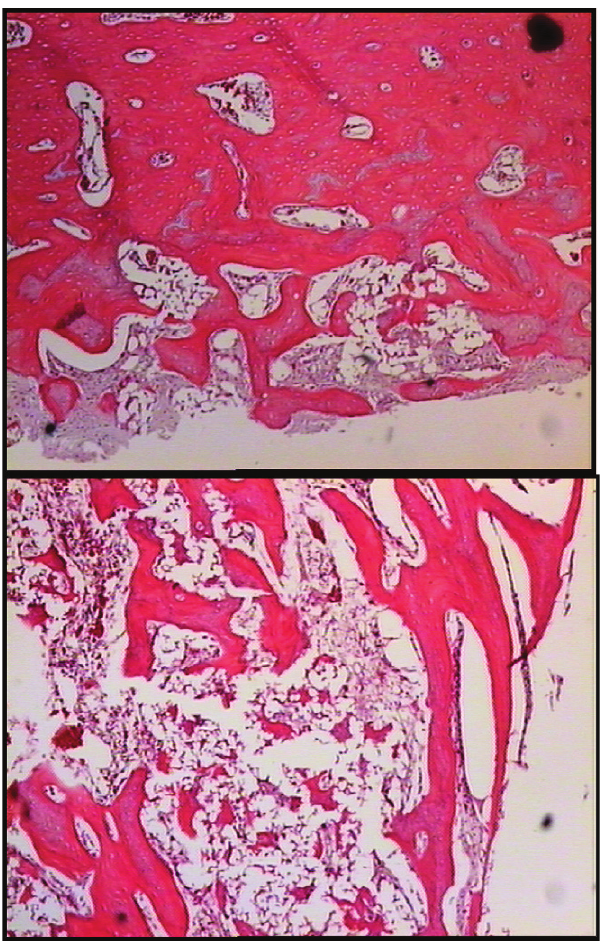
Figure 3 - Photomicrographs of bone defect consolidation in an animal in the PRP group (a) and the BMC group (b).